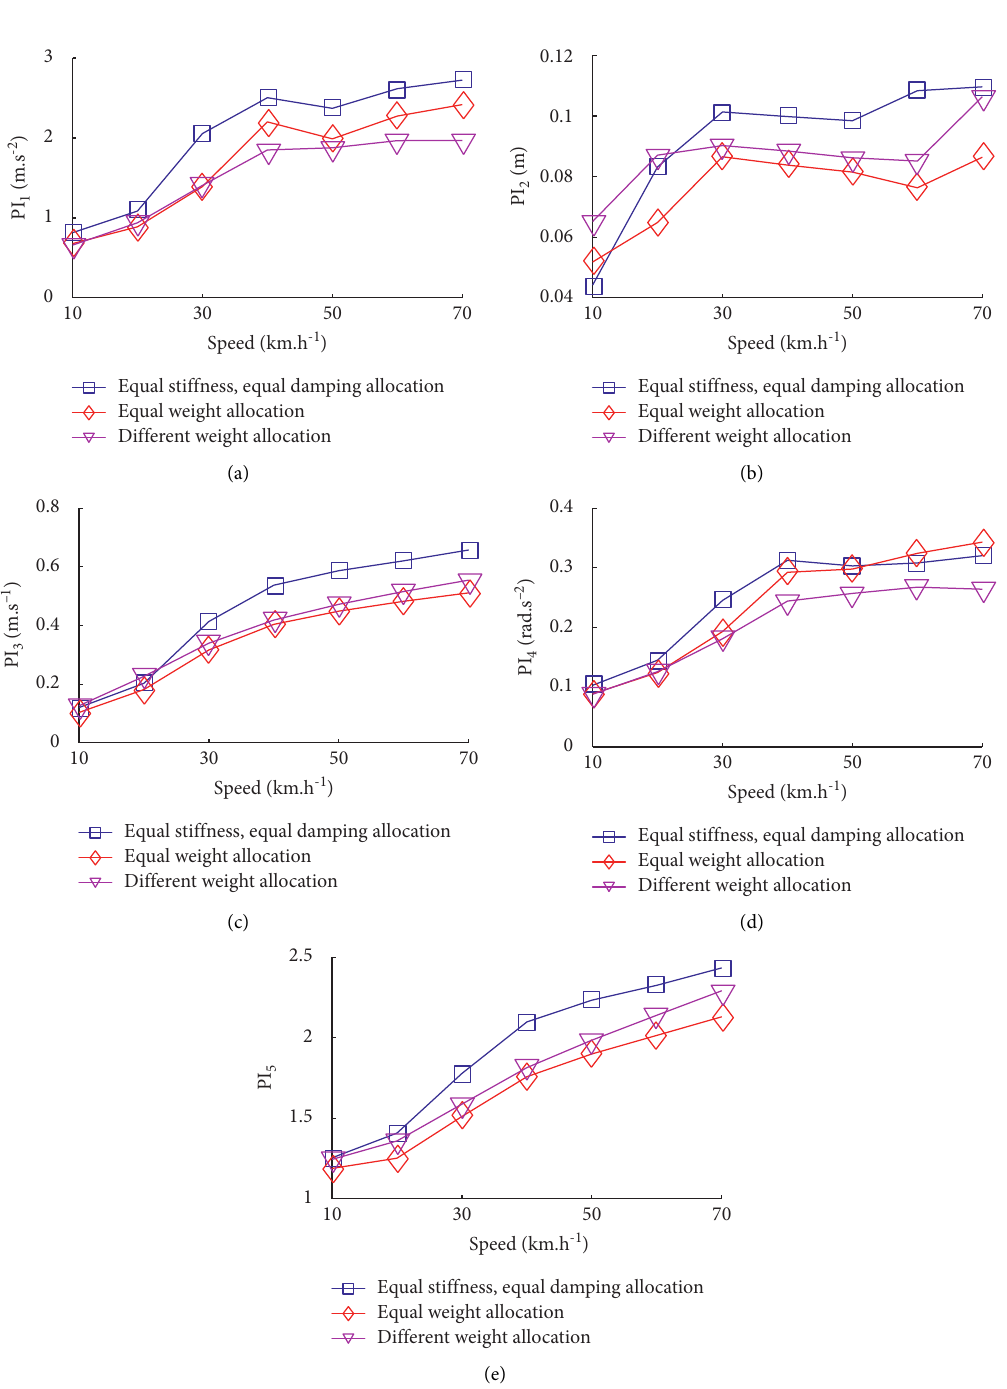
Figure 8: Comparison for the suspension system performance index (on Gobi